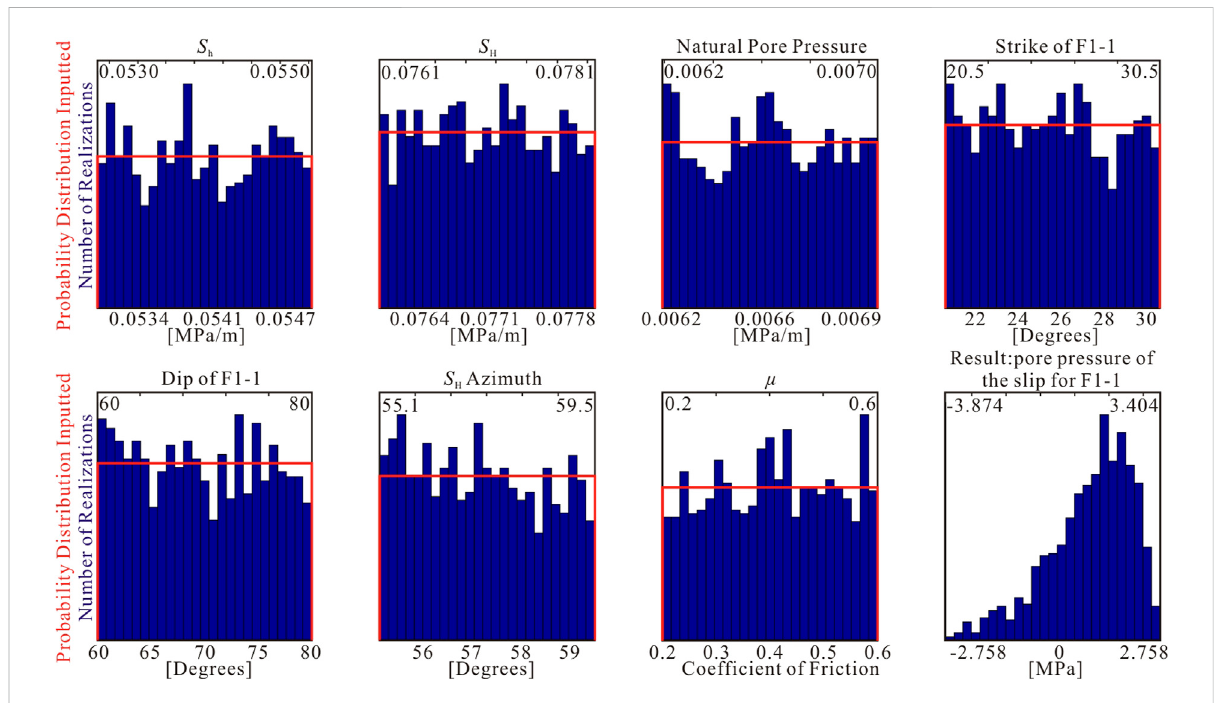
FIGURE 5 Probability distributions of the in situ stress fi eld and the characteristic parameters of the mapped fault